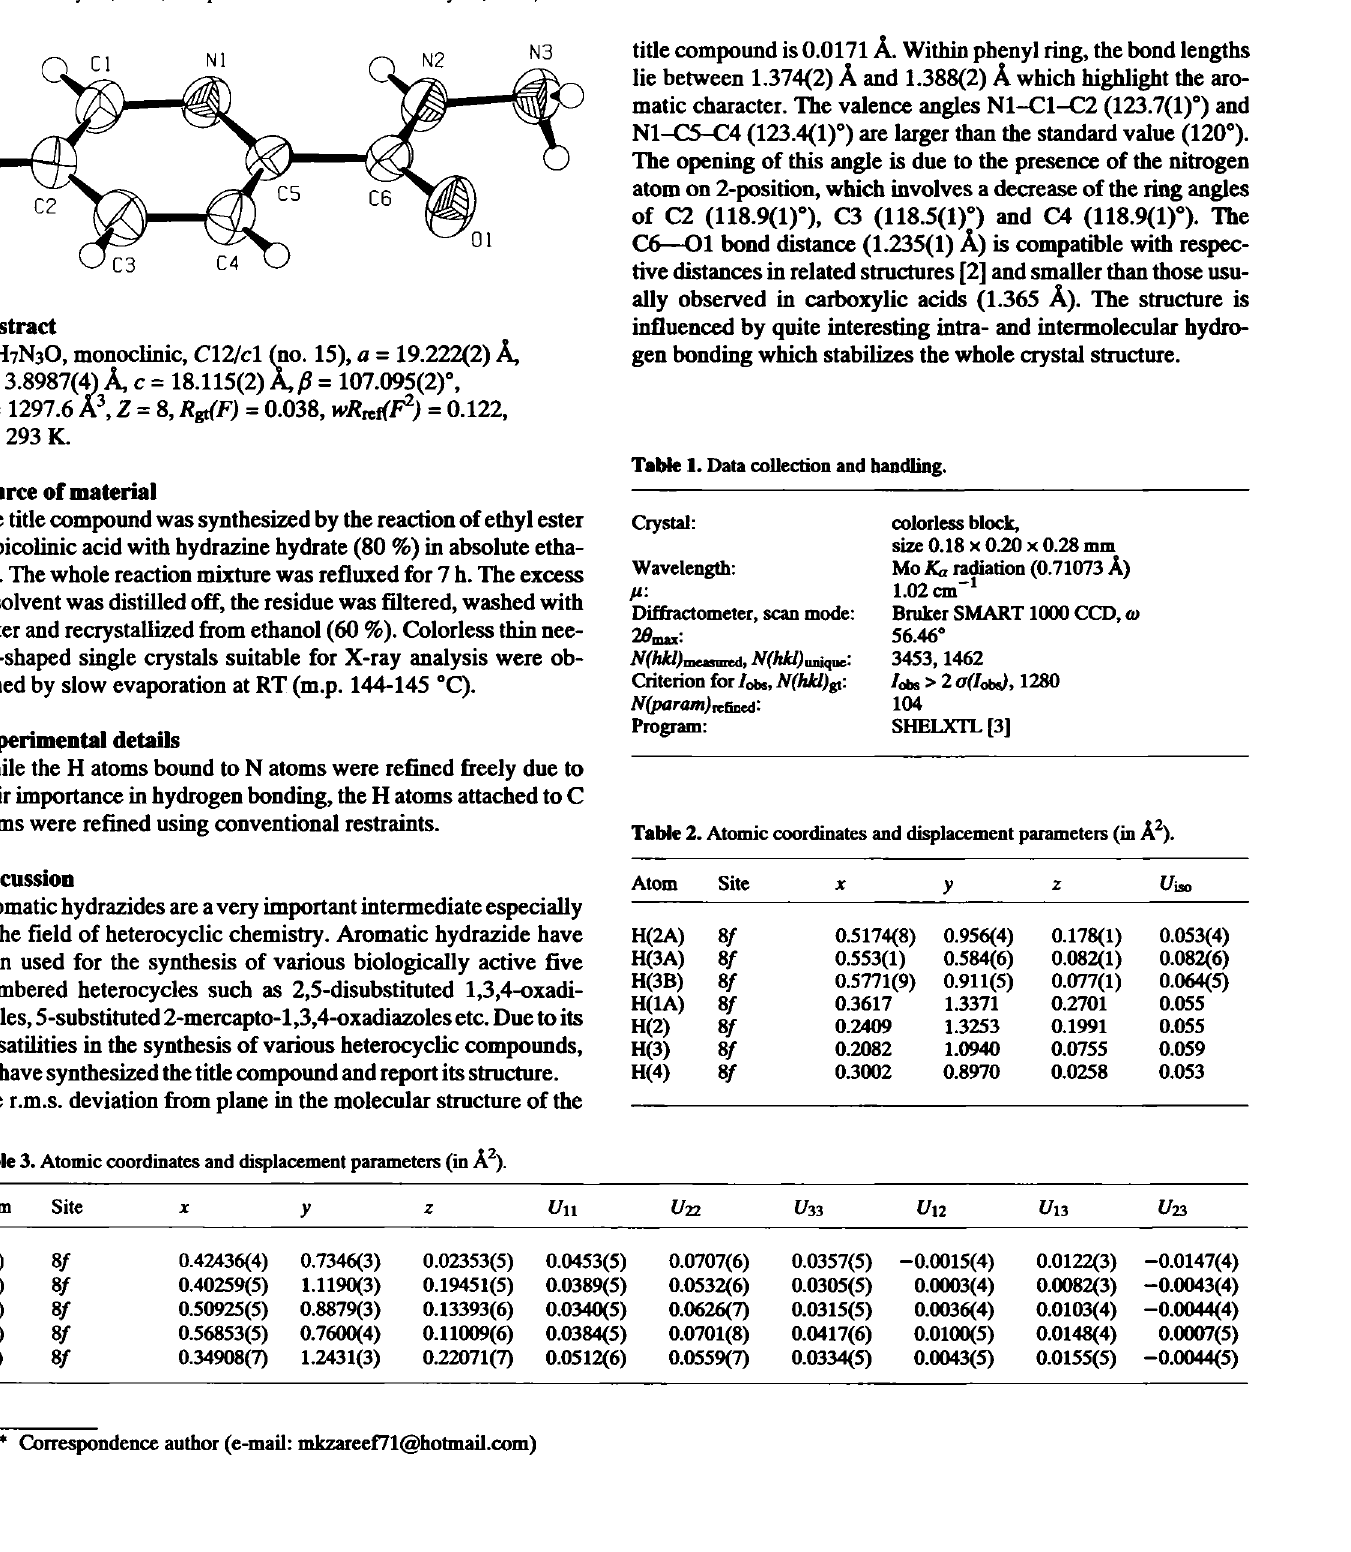
Table 3. Atomic coordinates and displacement parameters (in A 2